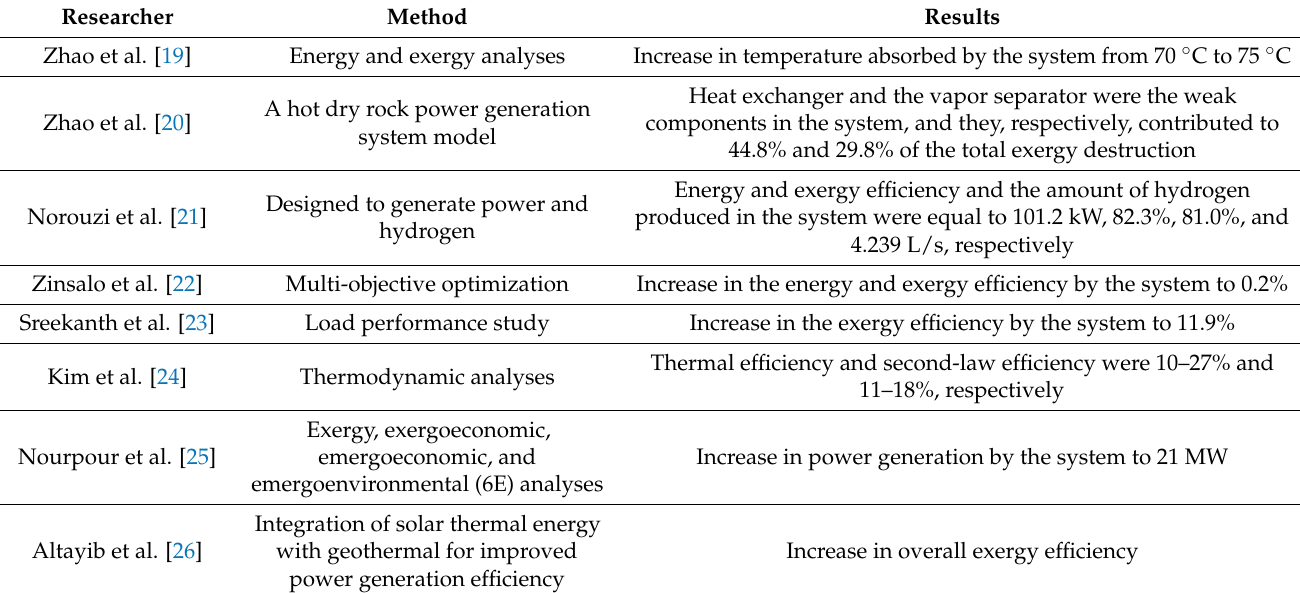
Table 1. List of different research studies focusing on energy and exergy analyses of geothermal Organic Rankine